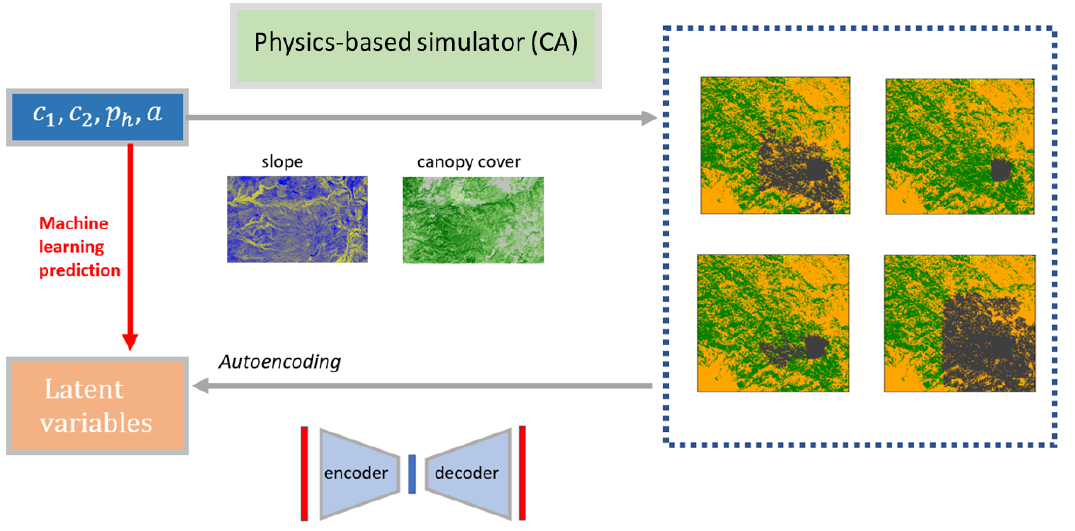
Figure 2. Flowchart of the forward prediction model with CA and ROM for a specific ecoregion. The data generation is performed with a set of parameters perturbed using